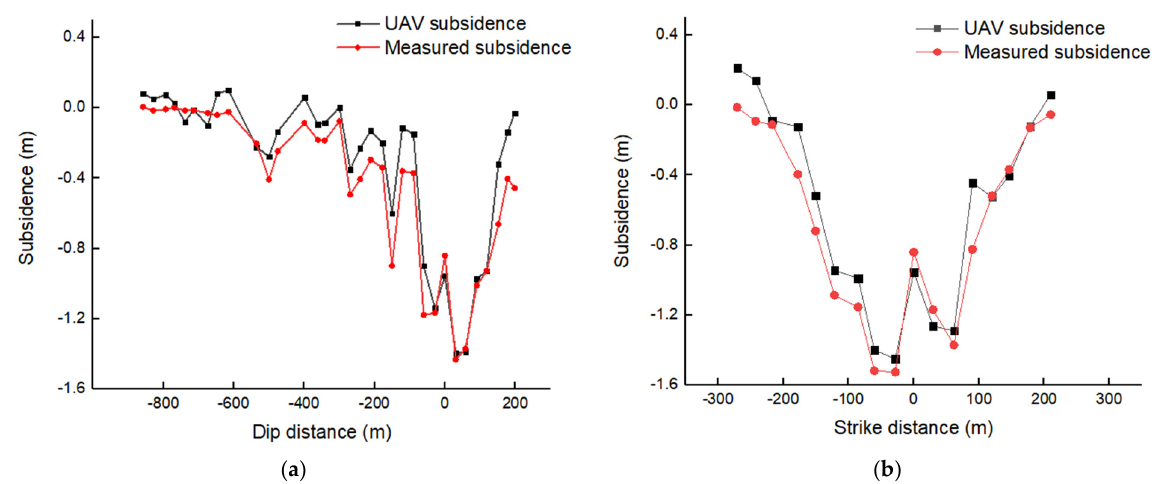
Figure 6. Comparison of UAV monitoring and leveling data along line A ( a ) and line C ( b ).